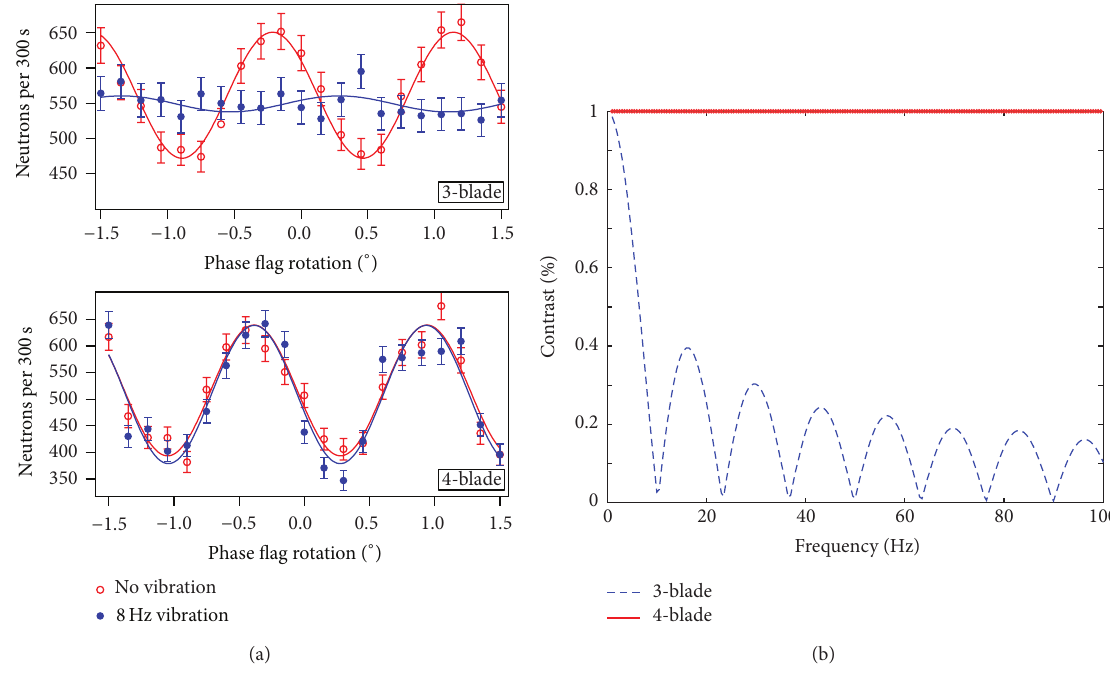
Figure 5: (a) Comparison data for standard (top) and DFS (bottom) interferometer designs without (red) vibrations and with (blue) 8Hz applied vibrations. (b) Numerical simulation of standard interferometer (blue) and DFS (red) contrast versus rotational vibrations [22].